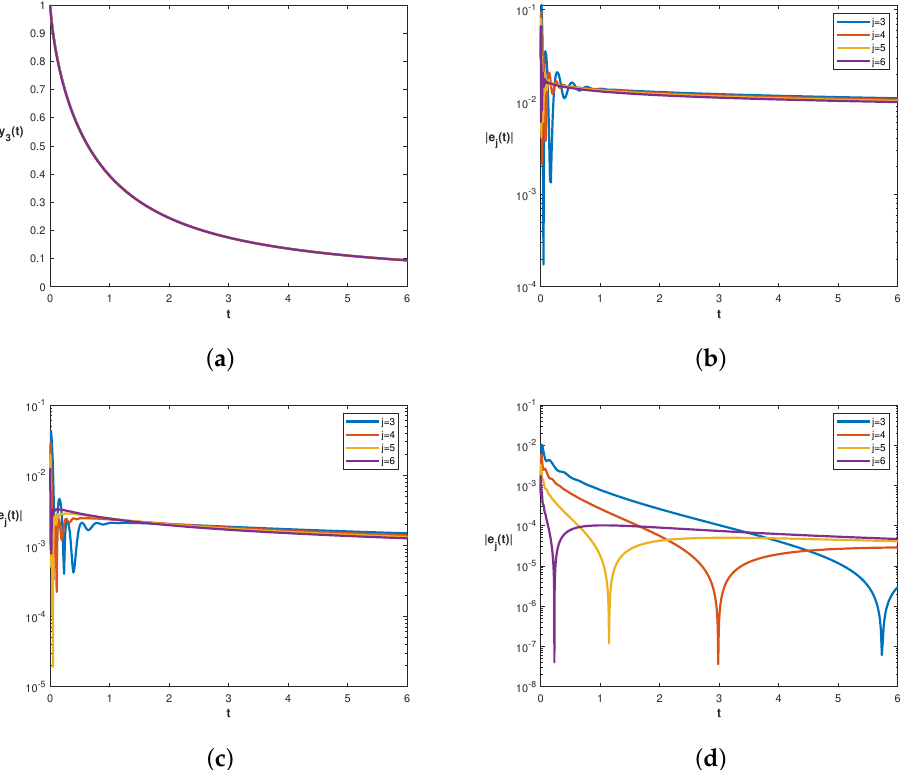
Figure 3. Example 2. ( a ) The numerical solution y 3 ( t ) (blue solid line) and exact solution (red dashed line). ( b – d ) The semilog plot of the error | e j ( t ) | for different values of j for γ = 0.25 (Panel ( b )), γ = 0.5 (Panel ( c )), and γ = 0.75 (Panel ( d